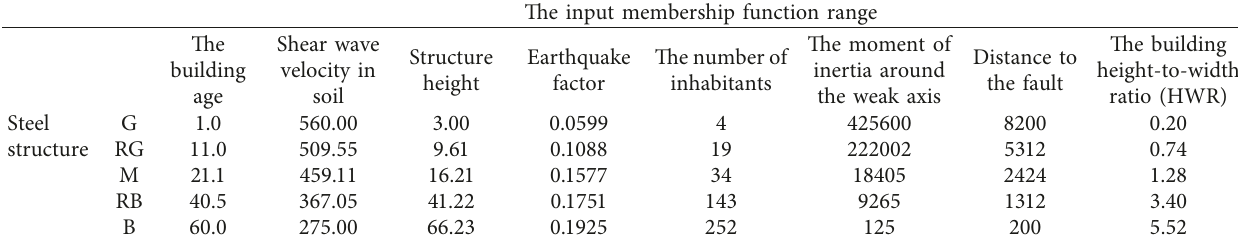
Table 2: The input membership function range of steel structures.